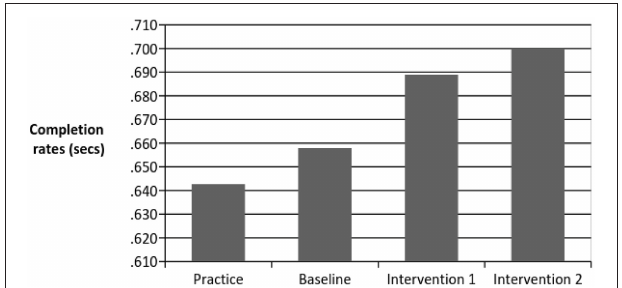
FIGURE 2 | Completion rates for performance over the course of the